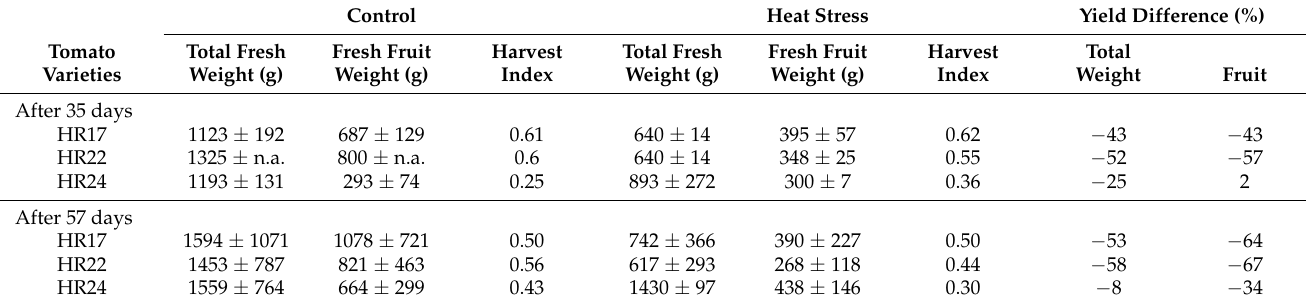
Table 1. Effects of long-term heat treatments on fresh weight (g), fresh fruit weight (g), harvest index of three cherry tomato accessions, including HR17, HR22, and HR24, in heat treatment and control conditions during two different time periods (35 days and 57 days). Yield differences of total weight and fruits were calculated for each accession in each heat-treated period. n.a. data are not available.